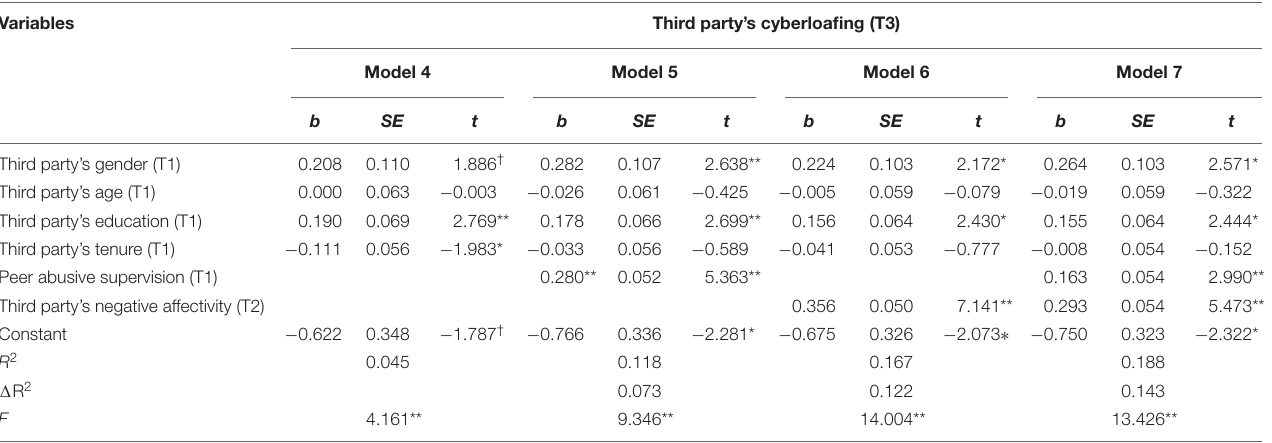
TABLE 5 | Regression results for the predictors of third party’s cyberloafing ( n = 355).